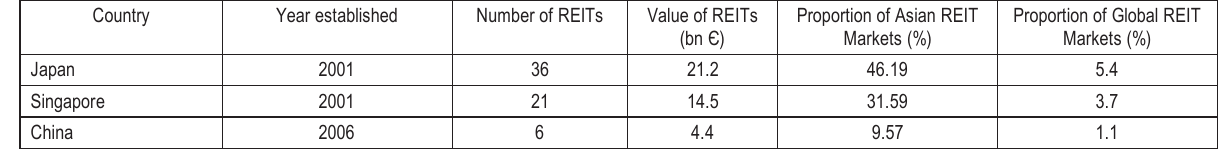
Table 1. The number and value of REITs in the markets of the examined Asian countries